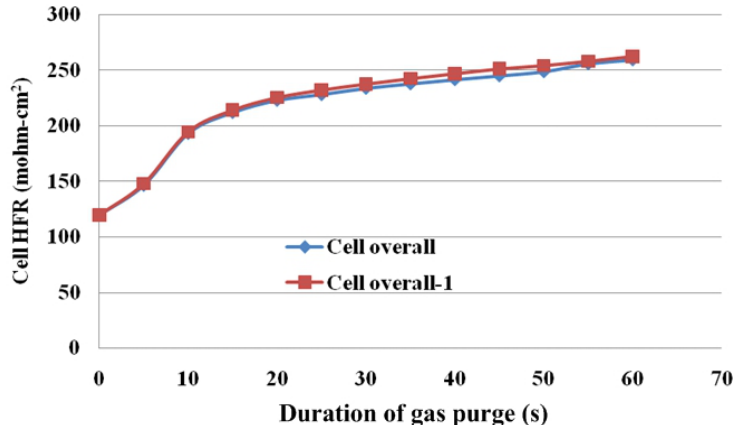
Figure 9. Short-term gas purging with the same purge conditions of 4 L/min.